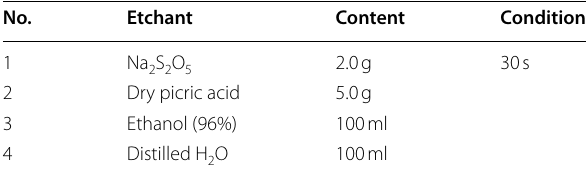
Table 3 First composition of LePera solution Table 4 Second composition of LePera